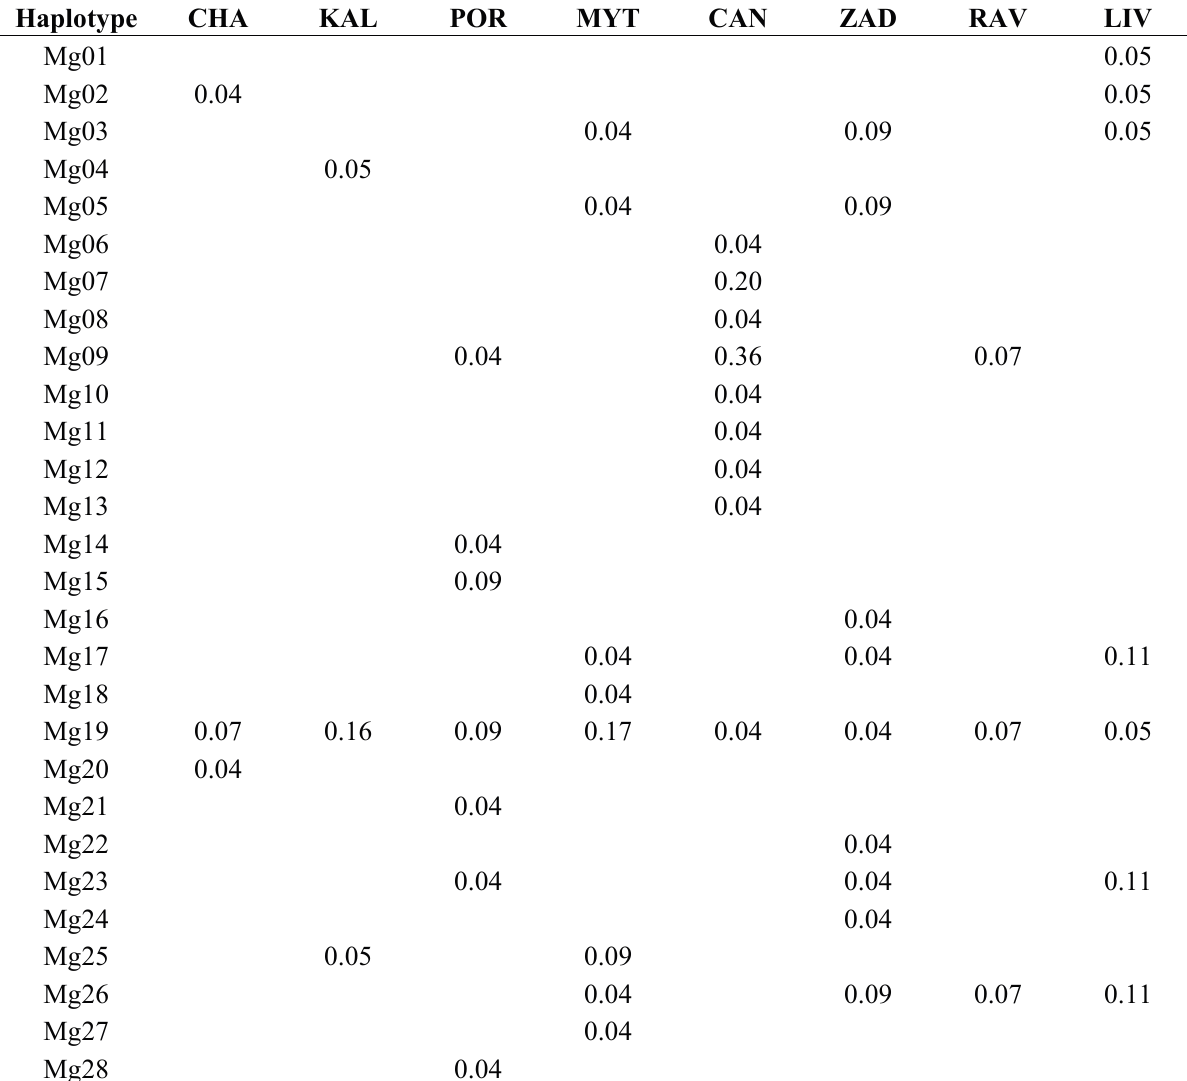
Table 1. Haplotype frequencies of the populations studied. Population codes as in Table 2.